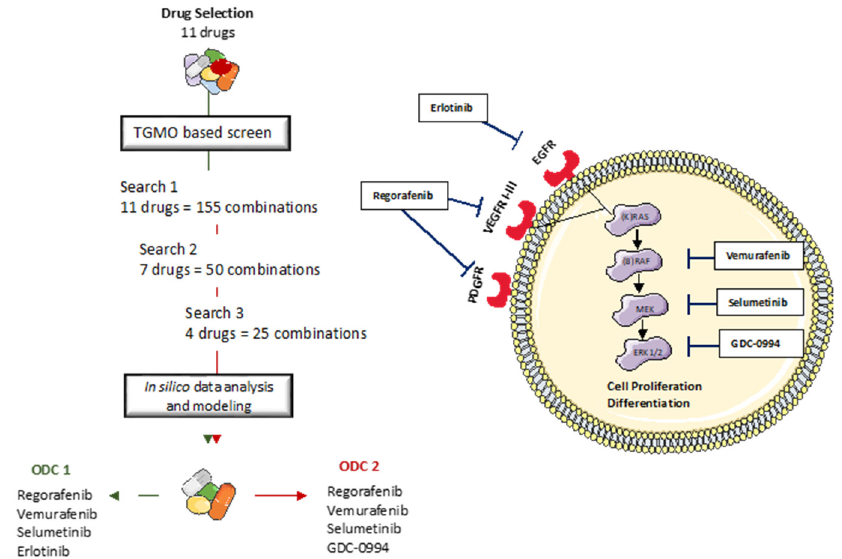
Figure 5. The TGMO-based screen. Through consecutive rounds of screening (Search 1–3) and data modeling [47], the strongest and most robust drug interactions define the final drug combination selection, to converge into two final ODC 1 and ODC 2 .